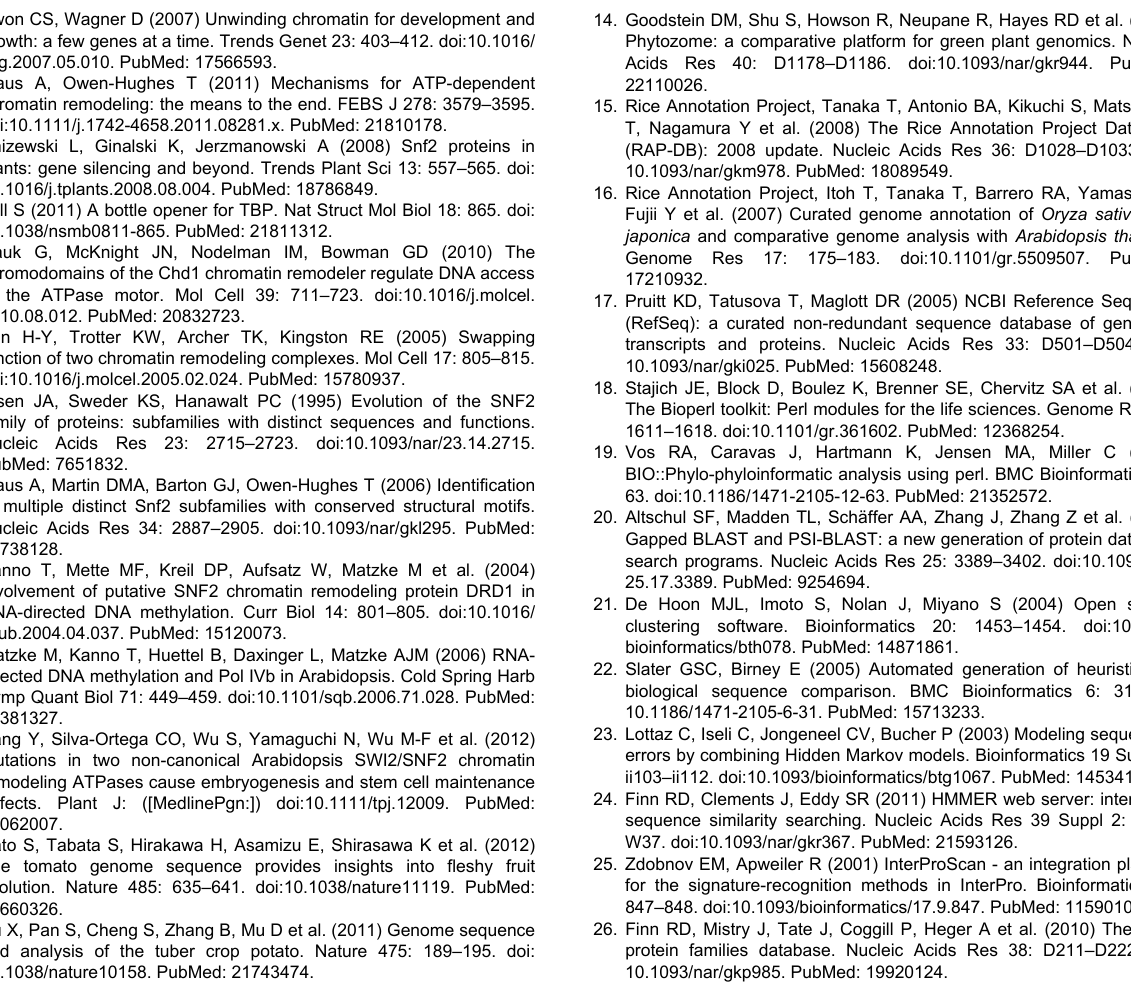
Table S3. RNA-seq libraries included in the analysis. Data are from the short read archive http:// www.ncbi.nlm.nih.gov/sra). The library and sample IDs refer to